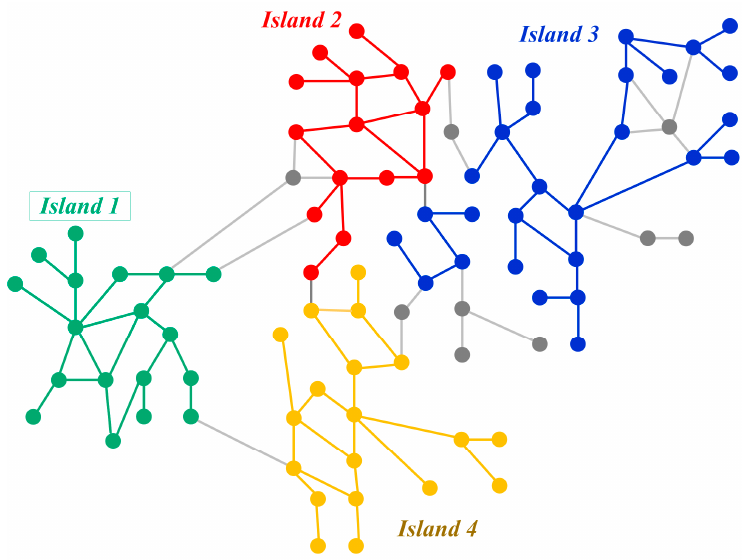
Figure 2. A Power system with four islands.